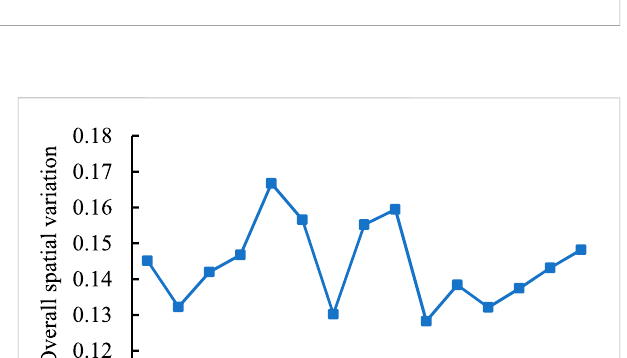
FIGURE 3 Spatial distribution characteristics of urban economic resilience.